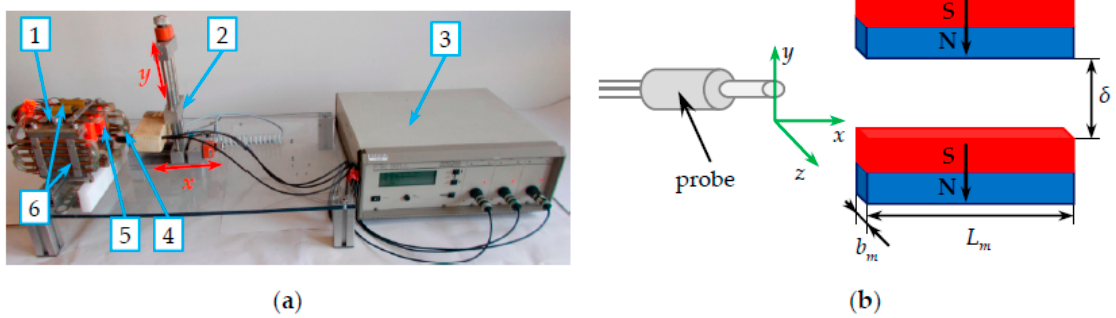
Figure 10. System for measuring the magnetic flux density in the exciter gap ( a ); 1—exciter, 2—probe shift system, 3—gaussometer, 4—probe, 5—guides for moving the MCM sample, 6—elements of the temperature stabilization system; diagram of the probe orientation and movement between the exciter magnets ( b ).